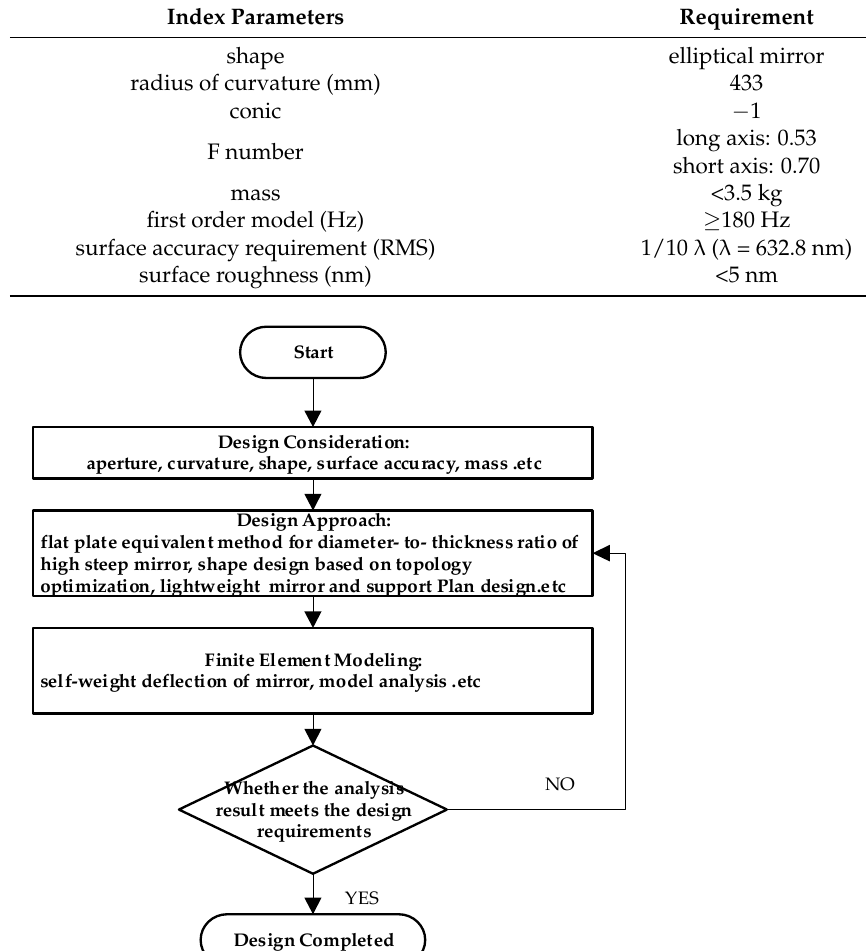
Table 1. Requirement of main mirror index.